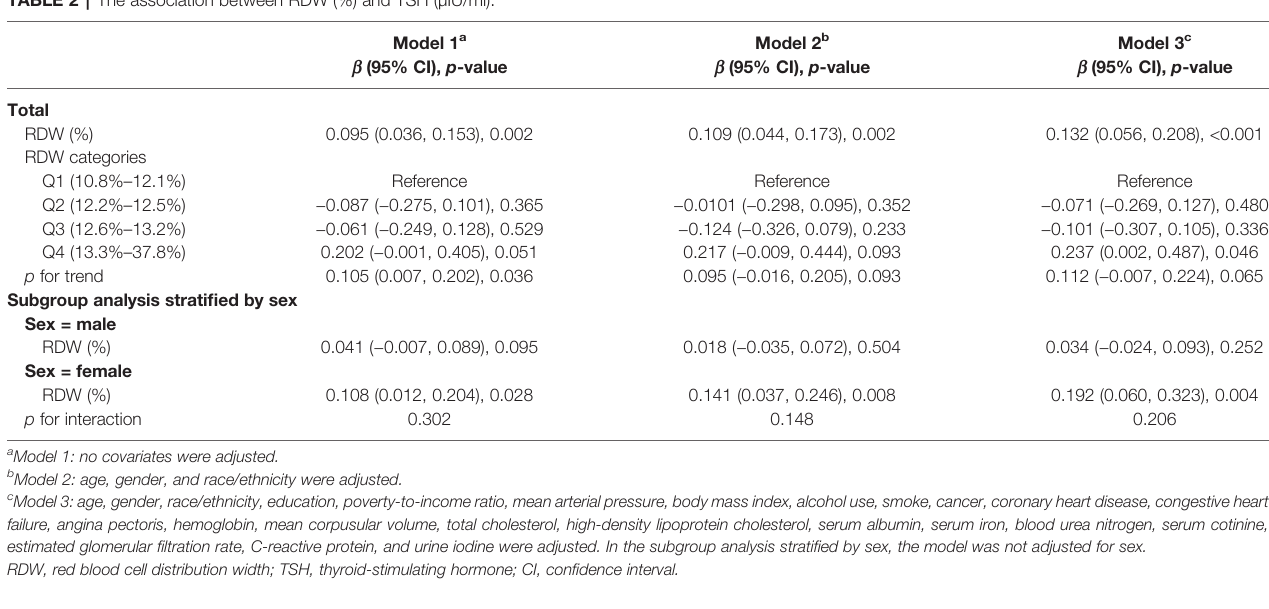
TABLE 2 | The association between RDW (%) and TSH